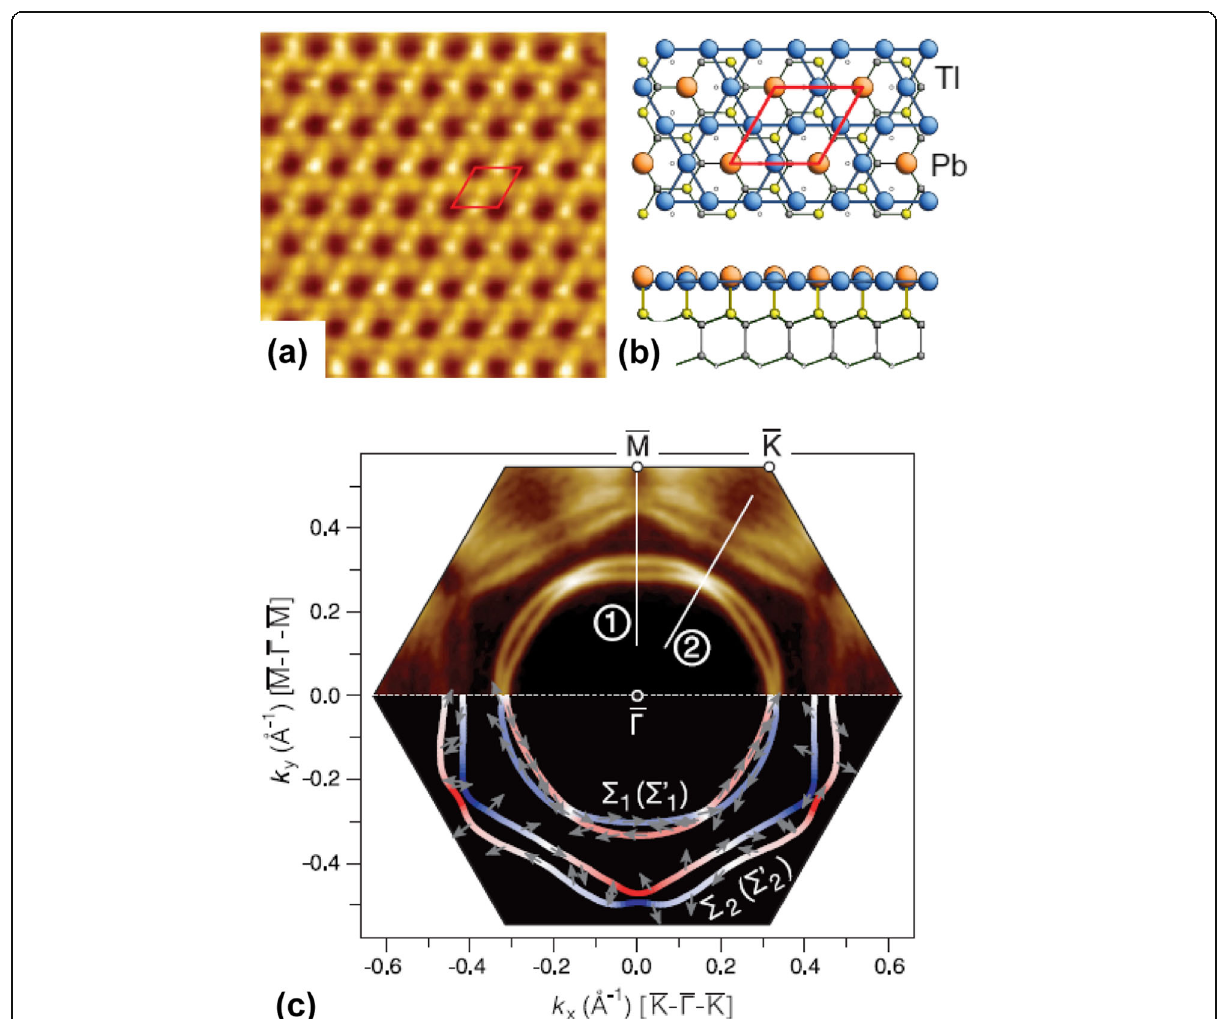
Fig. 4 Crystalline and electronic structures of Si(111)-( √ 3 × √ 3)-TlPb. a High-resolution (5 × 5 nm 2 ) STM image. b Atomic structure model. c Fermi surface obtained through ARPES measurement (upper panel) and ab initio calculations (lower panel). Reprinted figure with permission from A. V. Matetskiy et al. Phys. Rev. Lett. 115 , 147003 (2015) [31]. Copyright 2015 by the American Physical Society.